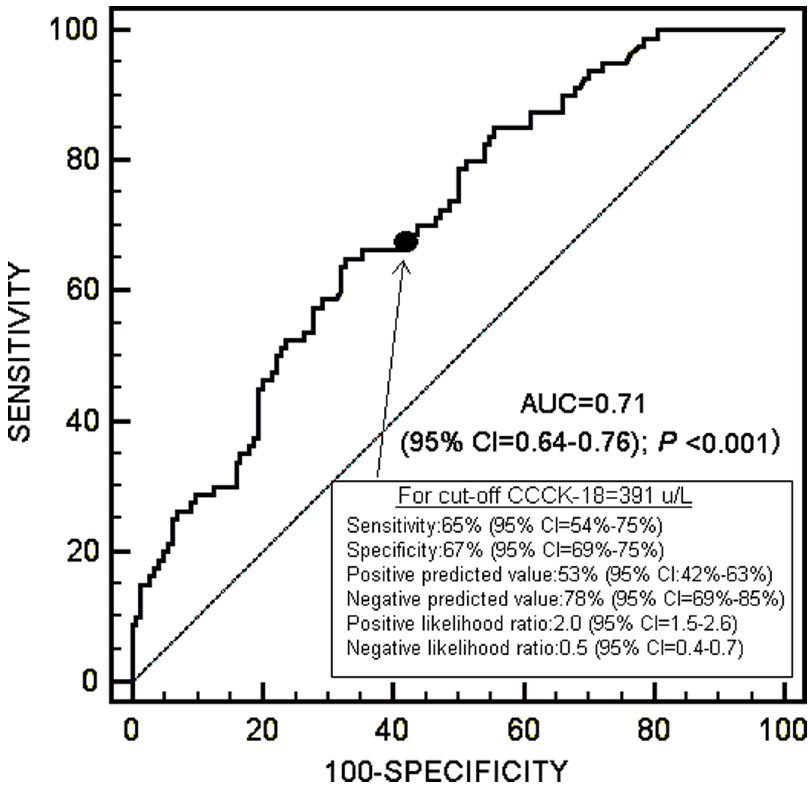
Figure 1. Receiver operation characteristic analysis using serum caspase-cleaved cytokeratin (CCCK)-18 levels as predictor of mortality at 30 days.